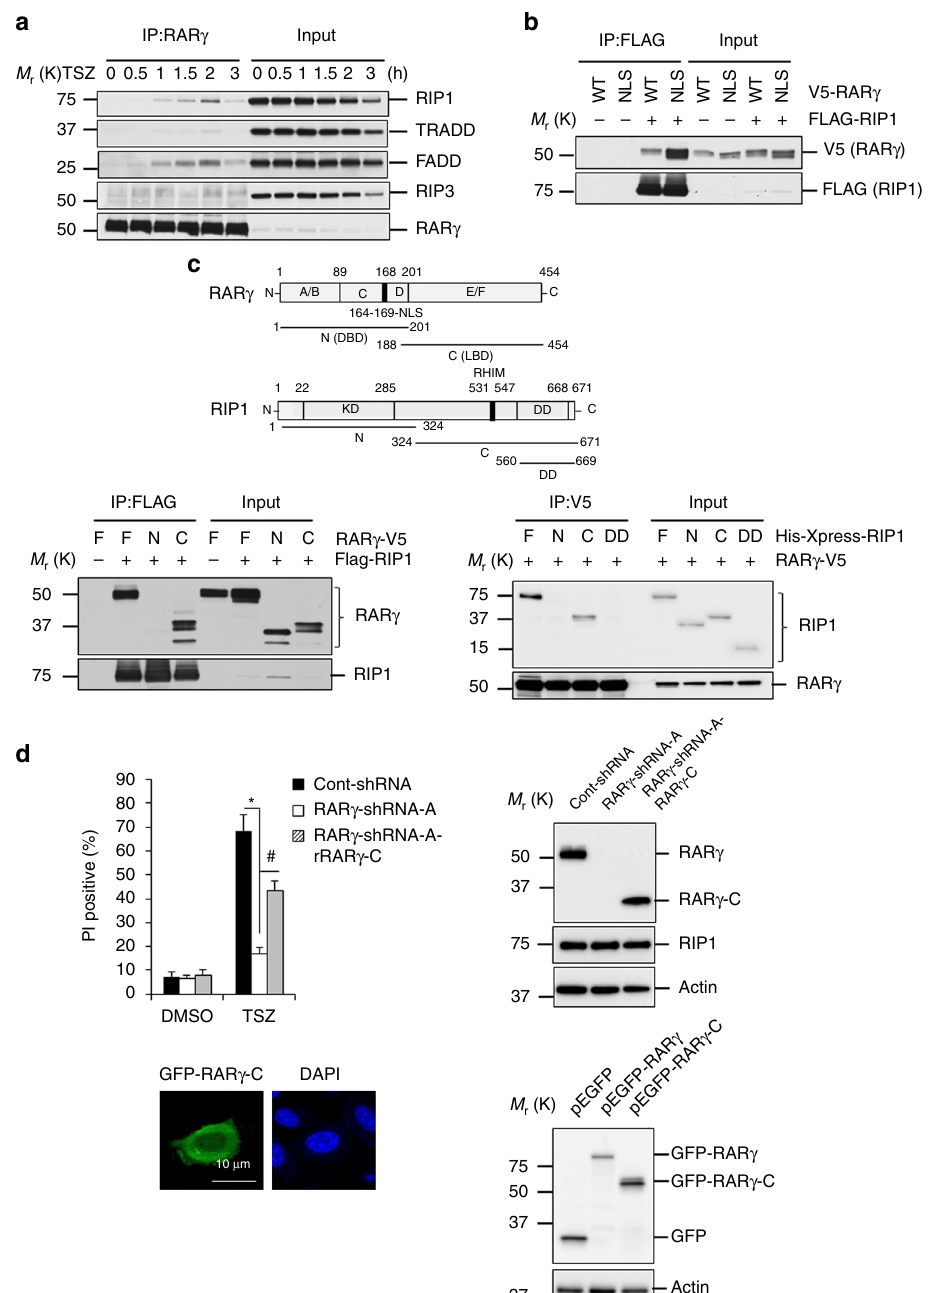
Fig. 4 RAR γ C fragment are important for protecting cell from TNF-induced necroptosis via interaction with RIP1. a Immunoprecipitation of HT-29 cells treated with TSZ for the indicated times. Cell lysates were immunoprecipitated with anti-RAR γ antibody and analyzed by immunoblotting with the indicated antibodies. b HEK293T cells were co-transfected with wild-type V5-RAR γ (WT) or the V5-RAR γ -NLSmut (NLS) and with or without FLAG-RIP1 plasmids. Cell lysates were immunoprecipitated using anti-FLAG (RIP1) antibody and analyzed with the indicated antibodies. c Scheme of RAR γ and RIP1 genes ( upper panel ). HEK293T cells were co-transfected with different fragment of RAR γ -V5 (F: full; N:1 – 201aa; C: 188 – 454aa) and with or without FLAG-RIP1 plasmids; or with different fragment of His-Xpress-RIP1 (F: full; N: 1 – 324aa; C: 324 – 671aa; DD: 560 – 669aa) and with or without RAR γ -V5. Cell lysates were immunoprecipitated using anti-FLAG (RIP1) or anti-V5 (RAR γ ) antibody and analyzed with the indicated antibodies. d HT-29 RAR γ -shRNA-A cells infected with rRAR γ -C. Cell death analysis of HT-29 cont-shRNA, RAR γ -shRNA-A, and RAR γ -shRNA-A + rRAR γ -C when treated with TSZ for 24 h was determined by PI staining using fl ow cytometry ( upper left panel ). (* P < 0.05 versus cont-shRNA; # P < 0.05 versus RAR γ -shRNA-A; ANOVA). The bars represent the mean ± s.e.m. of three experiments. Western blot analysis of cells as mentioned in left panel ( upper right panel ). Confocal microscopy of HT- 29 cells infected with GFP-RAR γ -C plasmid ( lower left panel ) ( blue : DAPI; green : RAR γ ). Western blot analysis of HEK293T cells were transfected with p- EGFP, p-EGFP-RAR γ and p-EGFP-RAR γ -C by using anti-GFP and anti-Actin antibodies ( lower right panel ). All blots and images above are representative of one of three